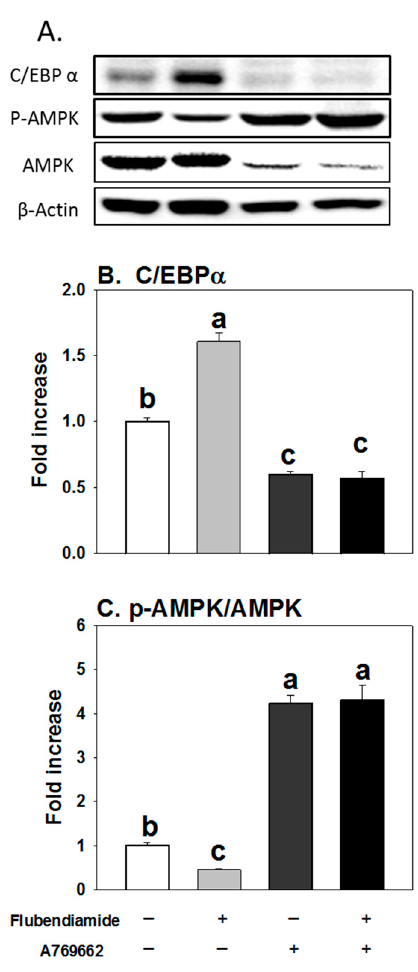
Figure 6. A769662 abolished the increased expression of C/EBP α and the decreased expression of pAMPK α induced by flubendiamide. ( A ) representative picture; ( B ) C/EBP- α , CAATT element binding protein- α ; ( C ) pAMPK α /AMPK α . Cells were treated with flubendiamide (10 µ M) or A769662 (10 µ M) for 8 days. Each value is expressed as the mean ± standard error of three separate experiments. Means with different letters were significantly different at p < 0.05 (a vs. b, a vs. c or b vs. c are significantly different).